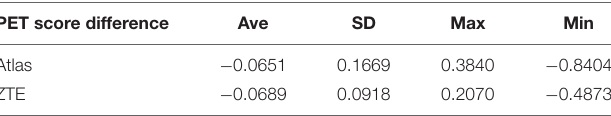
TABLE 1-B | Positron emission tomography score difference ( PETscore MRAC - PETscore original ) in each 2889 simulated dataset.